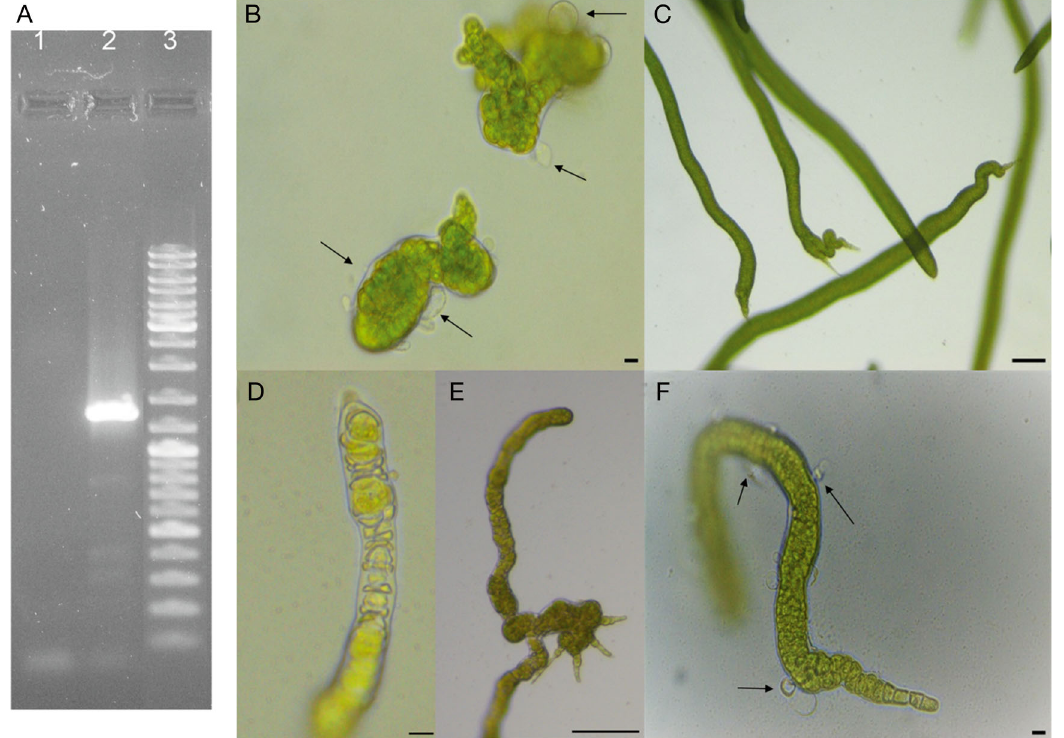
Fig. 2. Representative morphotypes within the Ulva tripartite community. (A) Demonstration of axenicity by amplification of a part of the 16S rDNA (520 bp) gene from the purified gamete stock solution (lane 1) and the non-axenic culture of U. mutabilis (lane 2). Lane 3 shows the gene ladder. (B−F) Using the ‘ Ulva bioassay array’, AGMPFs were determined in sterile-filtered wa- ter samples collected from the IMTA system. (B) Axenic callus-like morphotypes of Ulva were compared with (C) axenic cultures inoculated with sterile-filtered water samples (see also Fig. 3A,B) after 3 wk. Controls show the morphotypes inoculated with (D,E) Maribacter sp. only or (F) with Roseovarius sp. only. Arrows in (B,F) indicate the typical colourless protrusions from the exterior cell walls due to the lack of morphogens released by Maribacter sp. Scale bars = (B,F) –10 µm; (C−E) –100